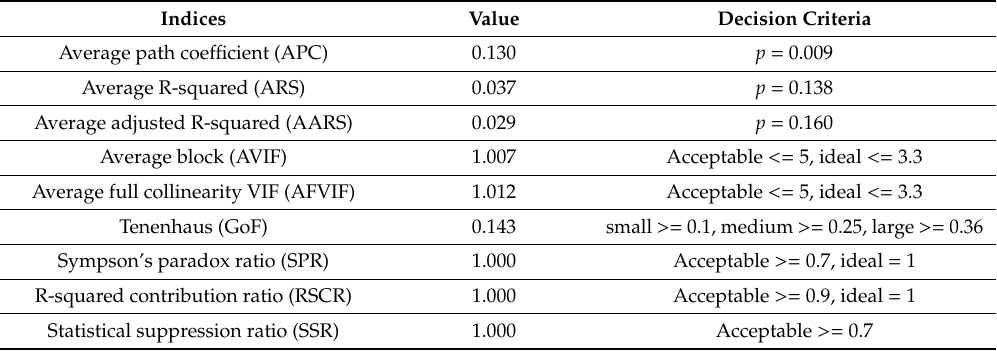
Table 8. Model 3. E ffi ciency indices for the relationships between work stress, physical activity, and